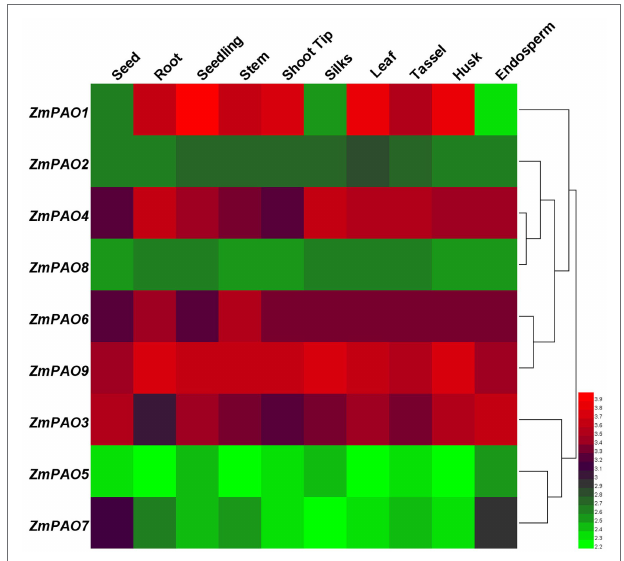
FIGURE 6 | Hierarchical clustering of expression profiles of ZmPAO gene family in ten tissues. Ten tissues from different developmental stages including seed, root, seedling, stem, shoot tip, silks, leaf, tassel, husk, and endosperm were investigated. The different tissues are marked at the top of each channel. Cluster dendrograms are displayed on the right. The color scale representing the value of the log 2 signal is shown on the right. Green represents low expression levels and red indicates high expression levels of the transcript